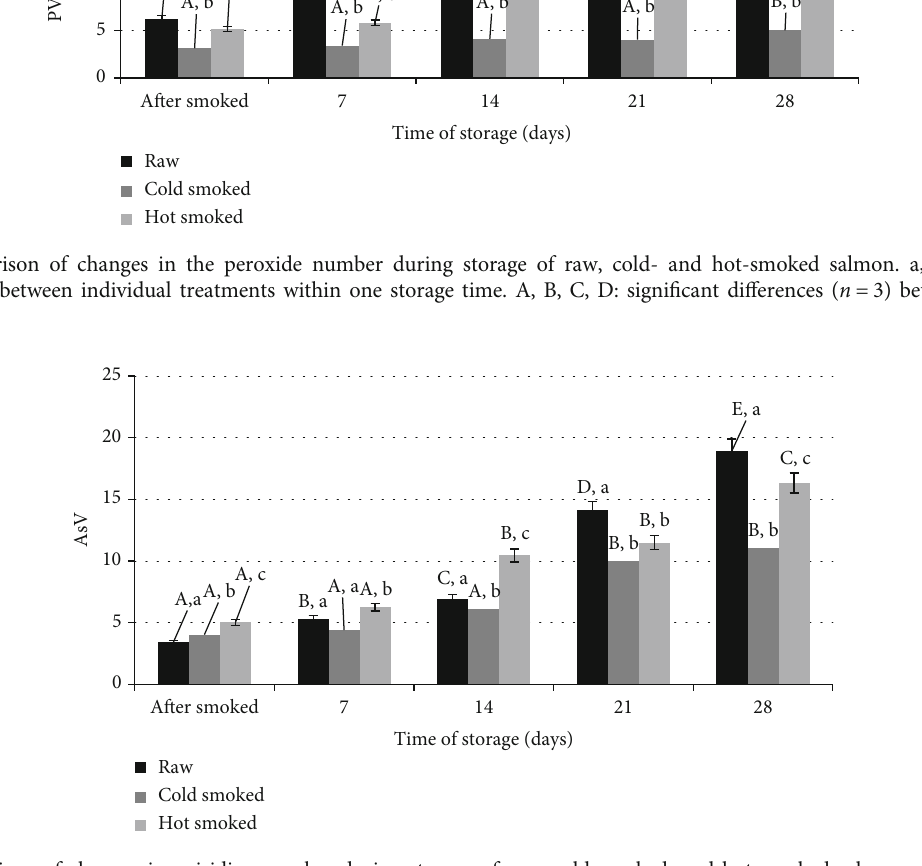
Figure 3: Comparison of changes in anisidine number during storage of raw, cold-smoked, and hot-smoked salmon. a, b, c: signi fi cant di ff erences ( n = 3 ) between individual treatments within one storage time. A, B, C, D, E: signi fi cant di ff erences ( n = 3 ) between treatments during